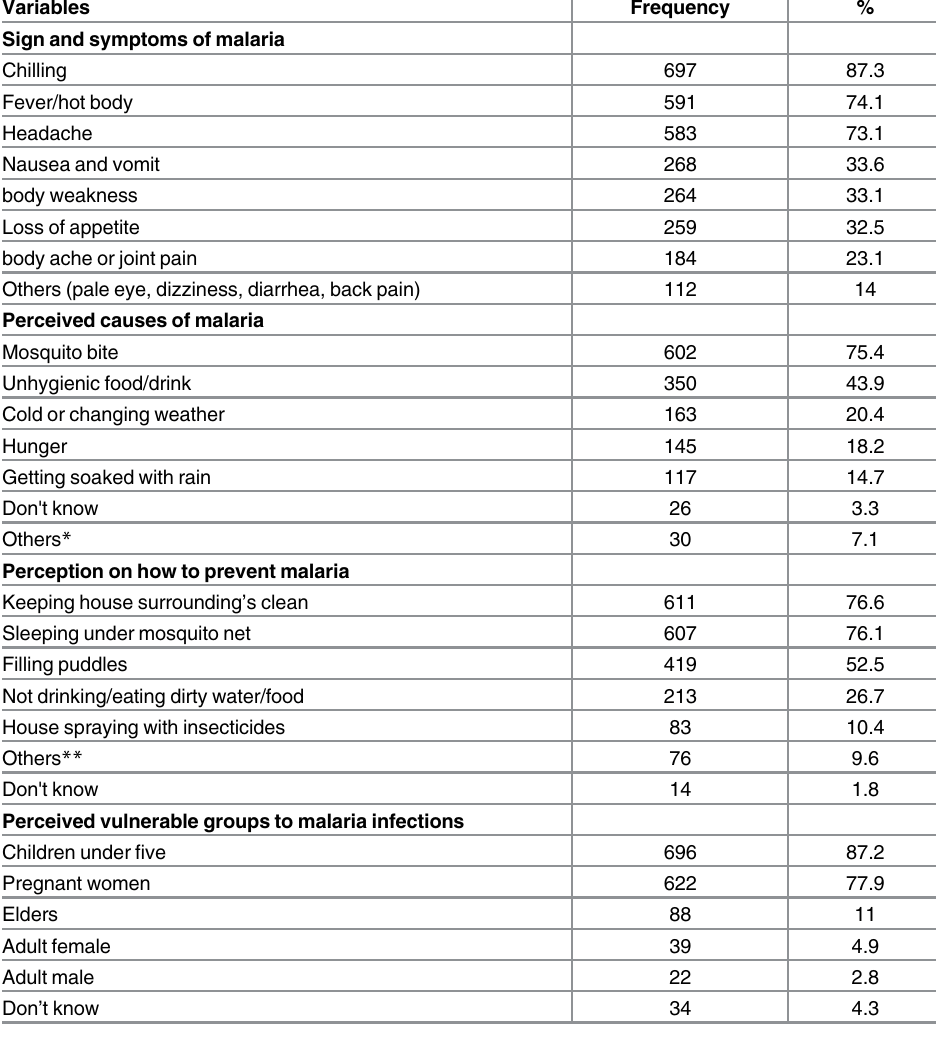
Table 1. Perceptions and knowledge of respondents related to malaria, Jimma, Ethiopia (Jan